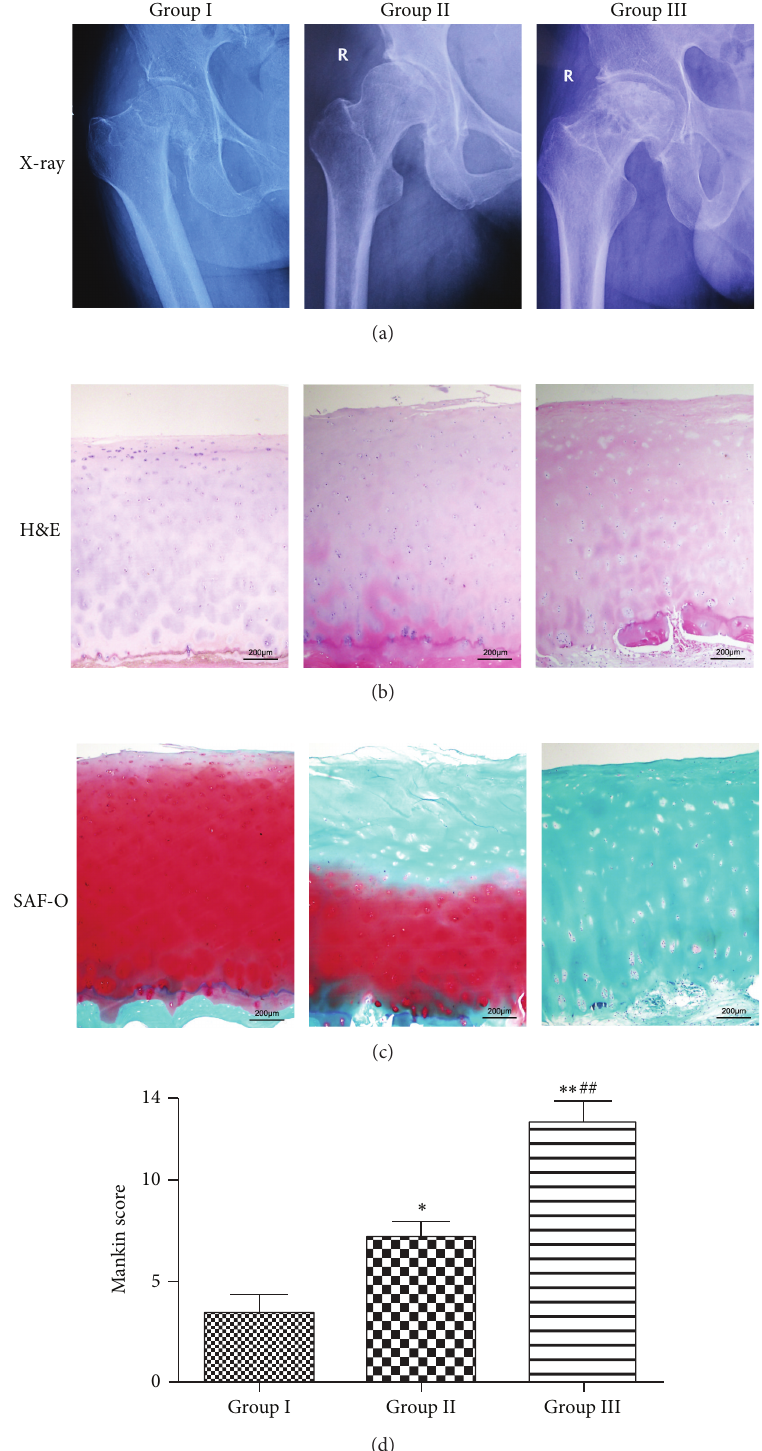
Figure 1: Articular cartilage is degraded in ONFH patients, and the degradation is associated with the pathogenesis of ONFH. (a) Representative X-ray images of three groups. (b) H&E staining of femur articular cartilage. Samples from femur articular cartilage of FNF patients and ONFH patients at different stages, as indicated, were harvested. (c) Safranin-O staining of femur articular cartilage. The cartilage staining was reduced with the progression of ONFH. Representation sections are shown. (d) Mankin score of femur articular cartilage from each group. Group II and group III got statistically significant higher score than group I ( ∗ 𝑃 < 0.05 , ∗∗ 𝑃 < 0.01 ). Group III got statistically significant higher scores than group II ( # 𝑃 < 0.05 , ## 𝑃 < 0.01